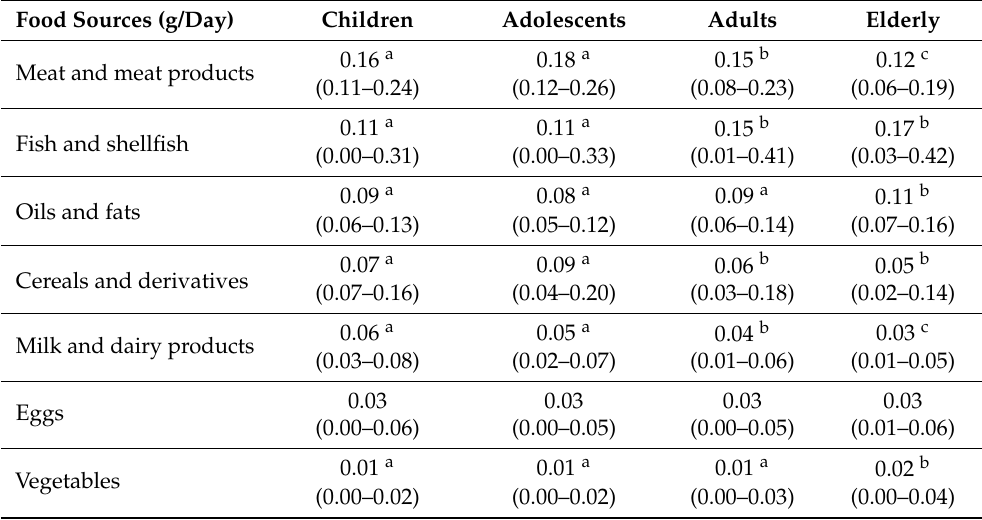
Table 13. Contribution of dietary food sources to total omega-3 intakes per age group among the ANIBES Study